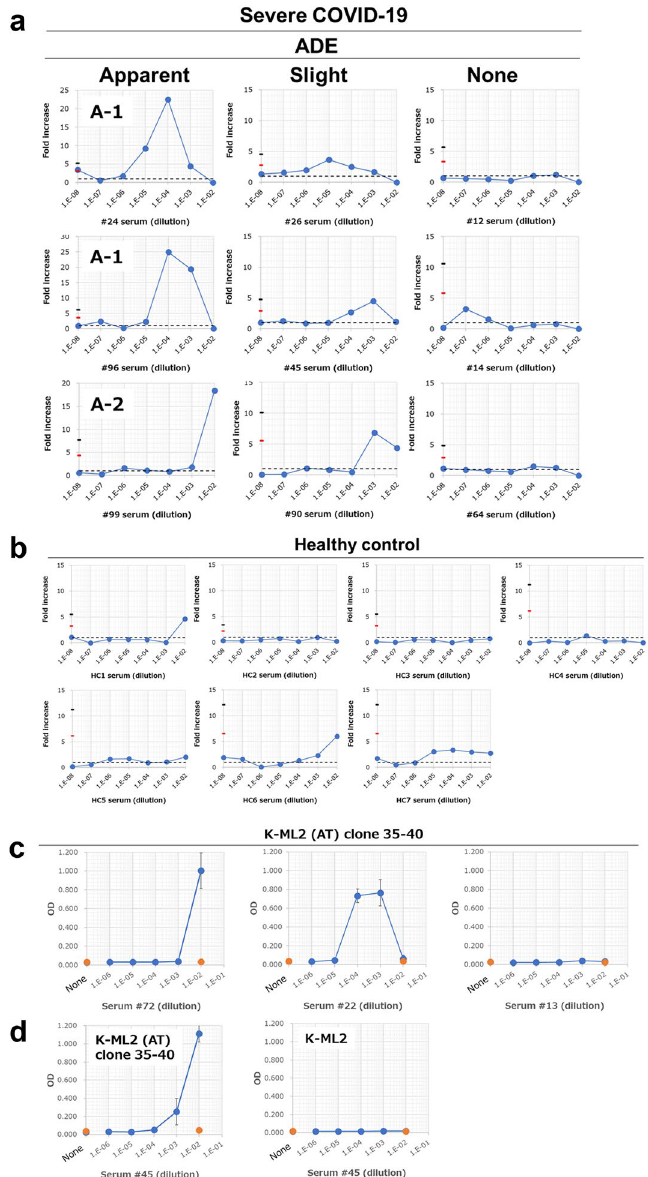
Figure 3. Infection- and IL-6 production-enhancing activity of sera derived from patients infected with SARS-CoV-2. K-ML2 (AT) clone 35 cells (2 × 10 4 /well in a 96-well flat plate) were cultured with SARS-CoV-2 (1.25 × 10 3 copies/μL) in the presence (N = 3) or absence (N = 6–9, control culture) of serially-diluted serum from ( a ) COVID-19 patients (N = 100) or ( b ) healthy volunteers (N = 7). The fold increase of virus progeny in SNs is shown. Red or black lines on the y-axis indicate the mean of control culture + a three or six SD cut-off, respectively. In each qRT-PCR experiment, the background control cultures (N = 6–9) were set. The raw data in each qRT-PCR experiment are summarized in Supplemental Table S3. Therefore, the values for red and black lines are different in each graph. The black dotted line indicates fold increase = 1. The results from COVID-19 patients were classified into three groups (Apparent, Slight, and None). Three representative examples in each group are shown in ( a ). All results from COVID-19 patients are shown in Supplemental Fig. S9. Patients of the Apparent group were further classified into two subgroups, A-1 and A-2, as indicated in ( a ). ( c ) K-ML2 (AT) clone 35–40 cells (2 × 10 4 /96-well flat plate) were cultured with (blue circles) or without (orange circles) SARS- CoV-2 (1 × 10 4 copies/μL) in the presence or absence of serially-diluted serum from COVID-19 patients. Three days later, the amount of IL-6 in culture SNs was measured by ELISA. The amount of IL-6 is plotted as OD values. Error bars indicate SD. N = 3. ( d ) K-ML2 (AT) clone 35–40 cells and parental K-ML2 cells were cultured as in ( c ) with the same serum #45. The production of IL-6 was measured (N =